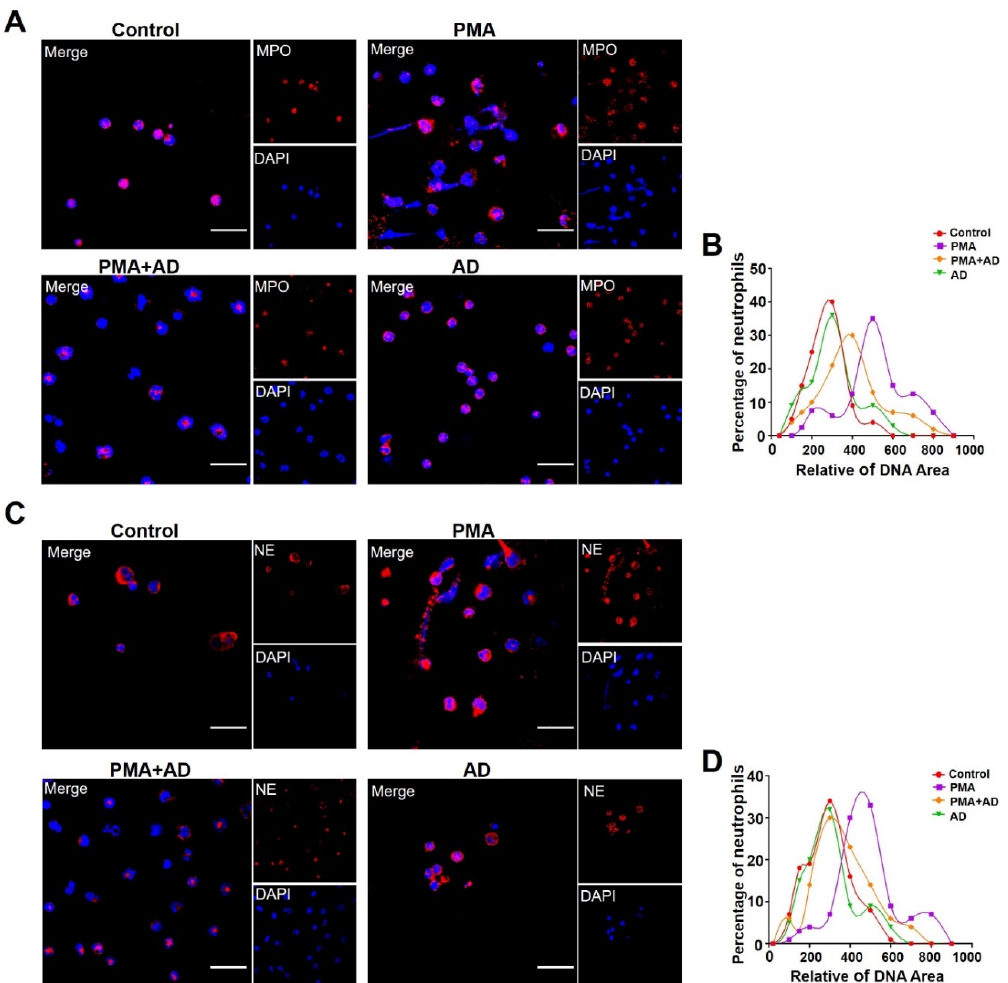
Figure 5. ( A , C ) PMA-induced NET formation was visualized via staining neutrophils with DAPI (blue) and an anti-MPO antibody (( A ); red) or anti-NE antibody (( C ); red) and observed using confocal microscopy, Scale bar represents 10 µ m. Representative images obtained from more than three experiments are shown. ( B , D ) Relative DNA area of 100 neutrophils in A ( B ) and C ( D ). The data were obtained from three independent experiments.